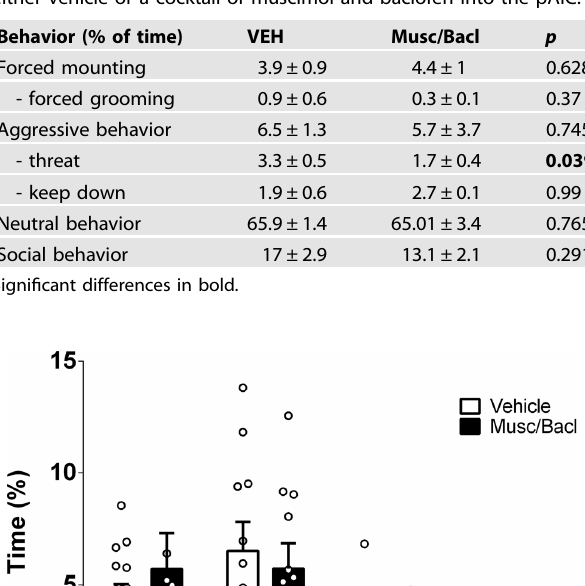
Table 5. Overview of t -test comparisons of the percentage of time displaying four main categories of behaviors (plus individual aggressive behaviors) in a 10 min SxAT in response to injection of either vehicle or a cocktail of muscimol and baclofen into the pAIC.